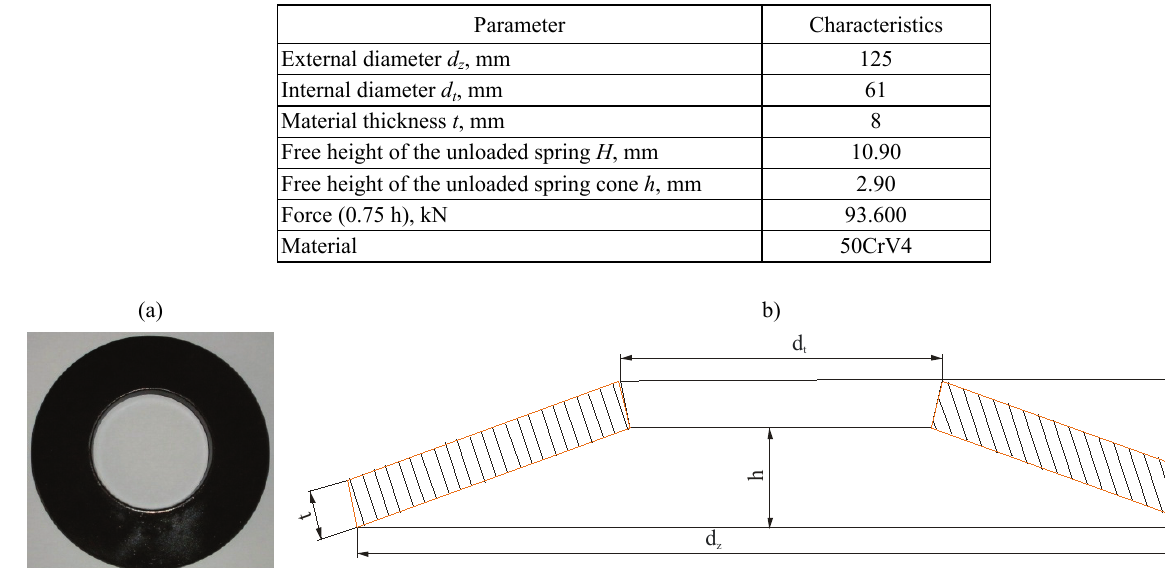
Fig. 11. The deformable component: (a) general view, (b) vertical cross-section, (c) on the test rig during measurements (by means of calliper), d – internal diameter (22 mm), d t – internal diameter of the disk spring (125 mm), D – external diameter of the component (141 mm), H – height of the component (55 mm), 1 – disk springs, 2, 3 – standard rock bolt washers, 4 – measurement hole, 5 – guide bar Table 1. Technical specification of the disk spring, Fig. 12